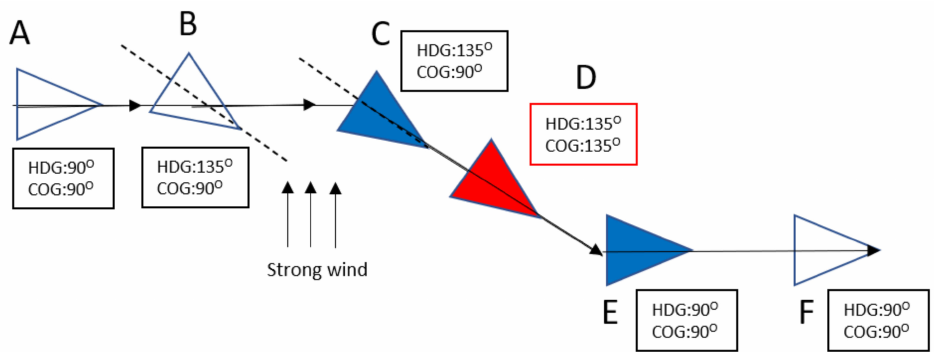
Figure 3. Judgment of COG transform.